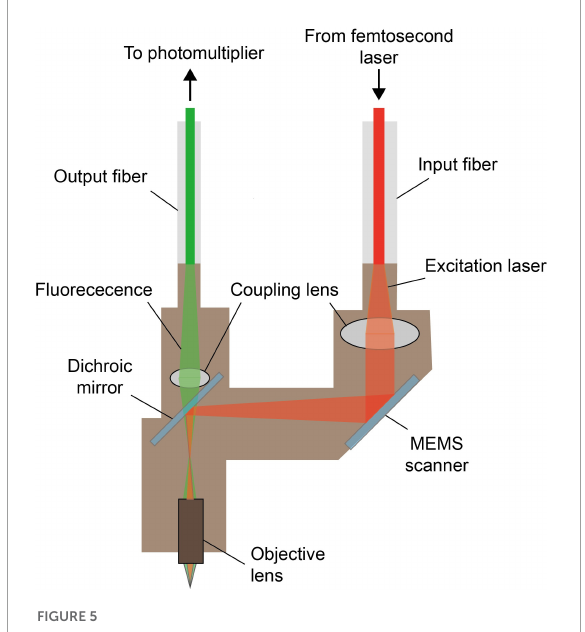
FIGURE5 Typical model of miniature multi-photon fluorescence microscope. The excitation light from the femtosecond laser is delivered to the headpiece through the input fiber, and the fluorescence signal is collected and transmitted to the photomultiplier through the output fiber. MEMS scanner provides the transverse scan needed for multi-photon